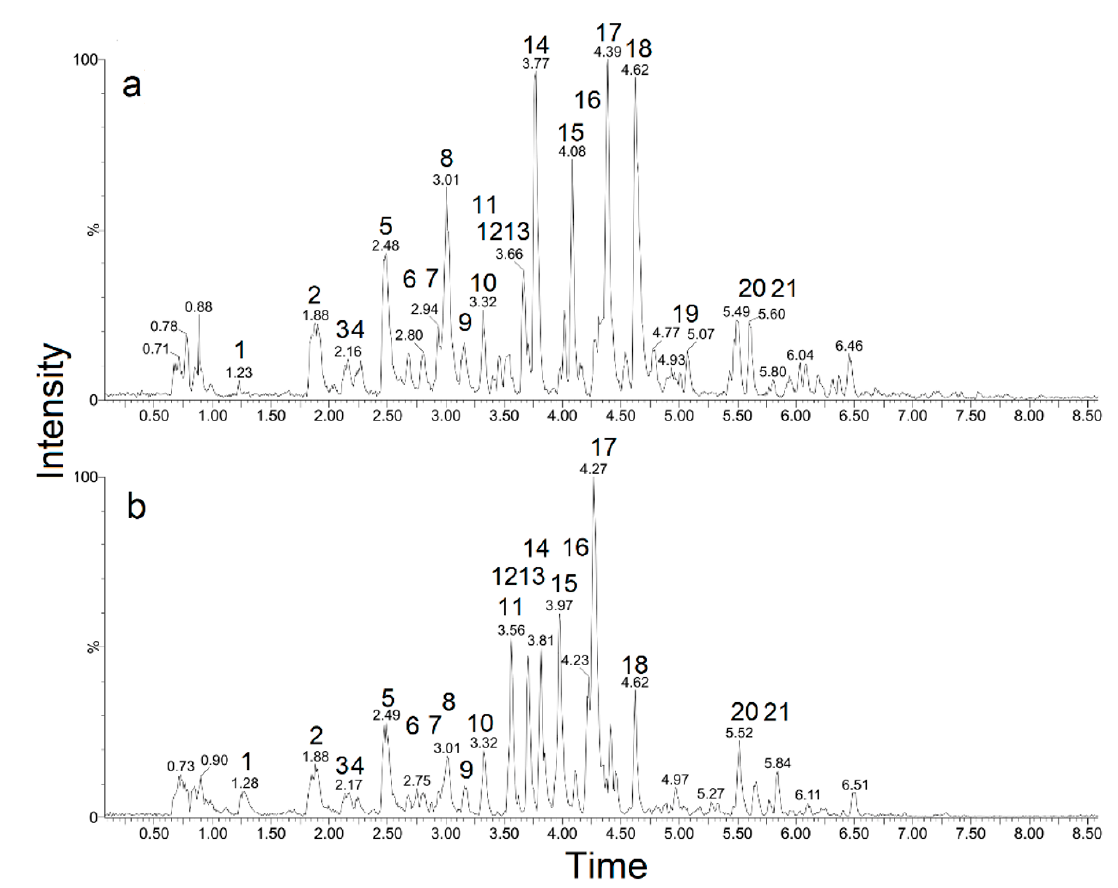
Figure 1. Chemical chromatogram of the ( a ) hydroethanolic (HELG) and ( b ) aqueous (AELG) extracts obtained from G. hirsutum leaves. Table 1. Chemical profile of the aqueous and hydroethanolic extracts obtained from the leaves of Gossypium hirsutum L.